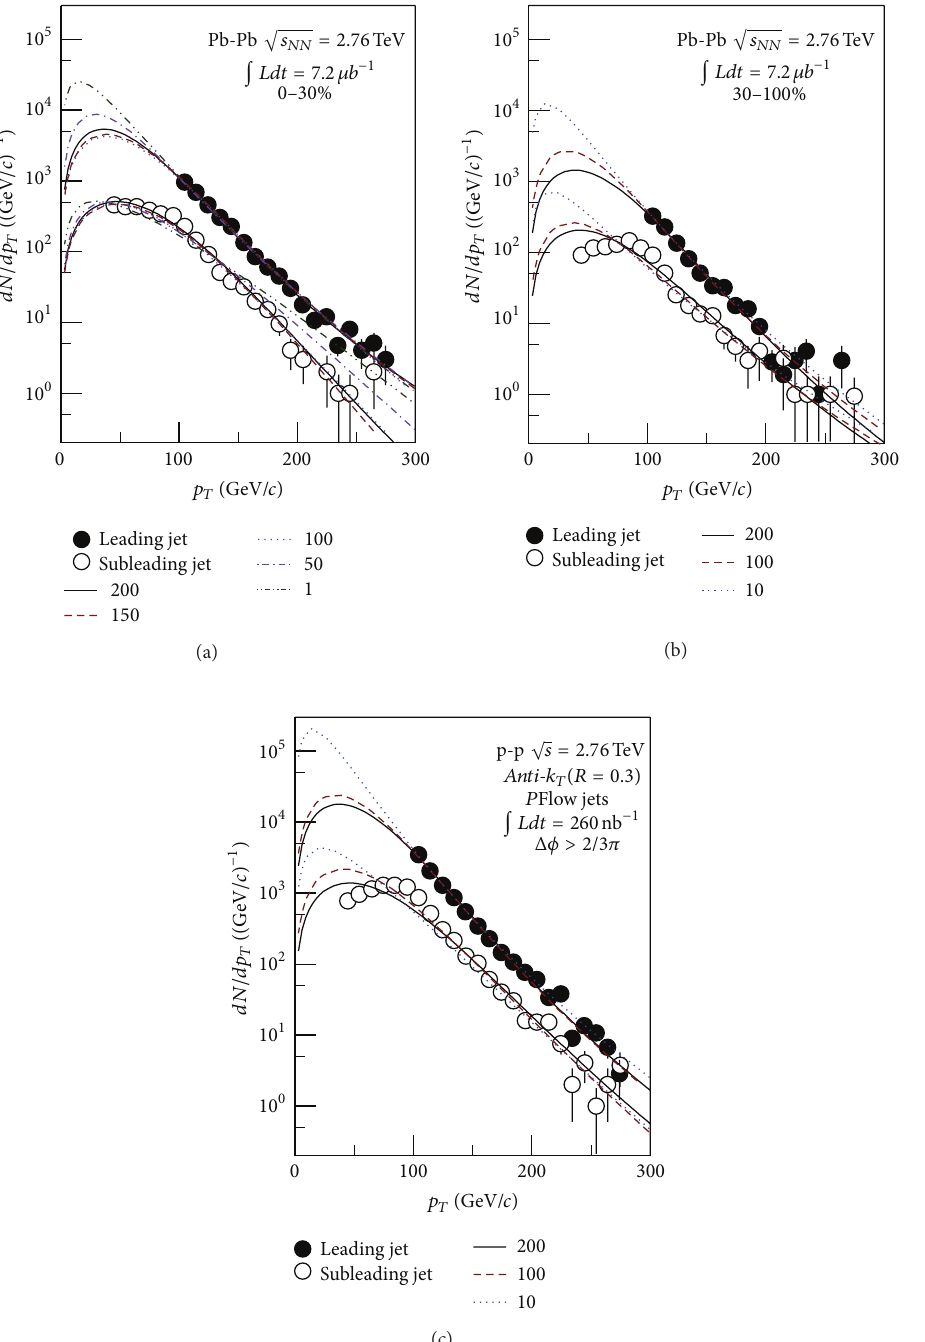
Figure 3: Dependence of jet 𝑝 𝑇 spectrum on 𝑚 0 in the L´evy distribution. The same experimental data [13] as those cited in Figure 2 are used. Different values of 𝑚 0 correspond to different results shown in the figure by different types of curves. The unit of 𝑚 0 is GeV/c 2 .